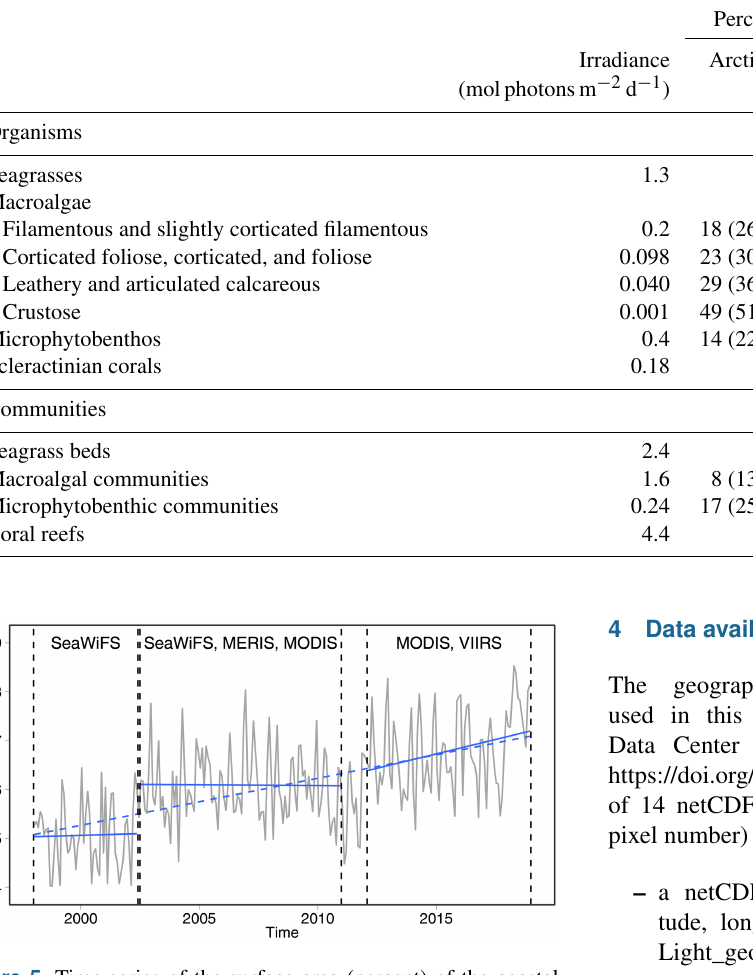
Figure 5. Time series of the surface area (percent) of the coastal nonpolar region receiving more than 2molphotonsm − 2 d − 1 . The linear regression between 1999 and 2018 is shown as a dashed line, while the result of separate linear regressions for the three time pe- riods with the same set of ocean color sensors is shown as a solid